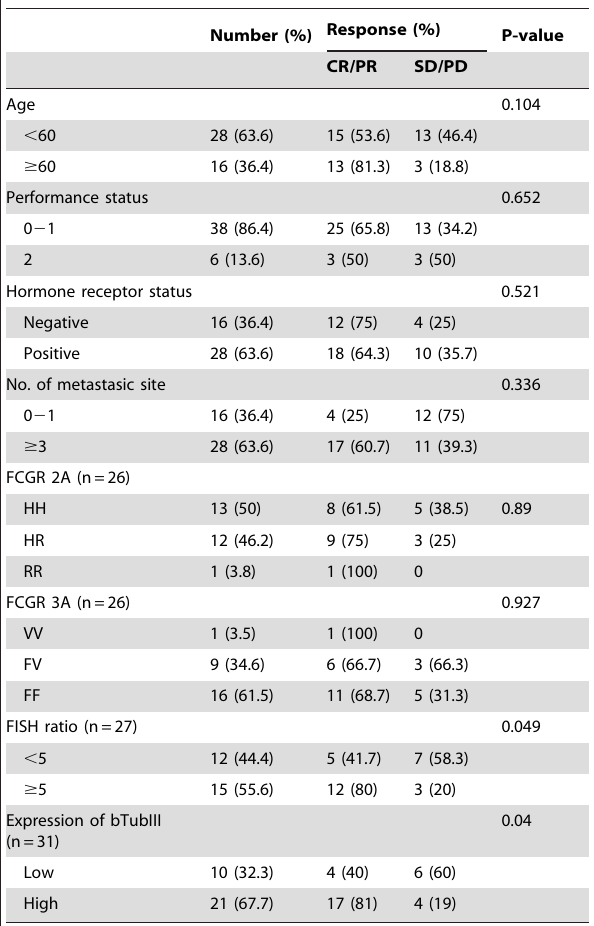
Table 3. Clinical response according to baseline characteristics and biomarkers.